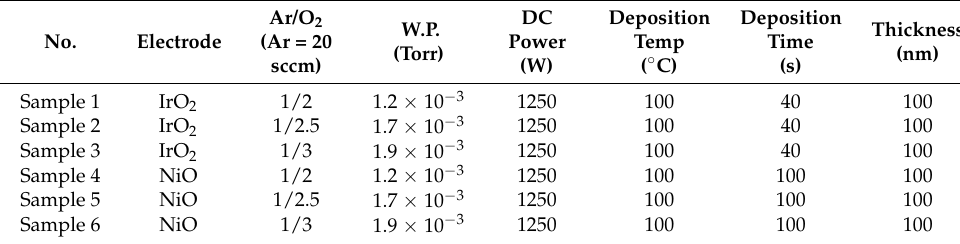
Table 1. Deposition parameters of IrO 2 and NiO electrode films.